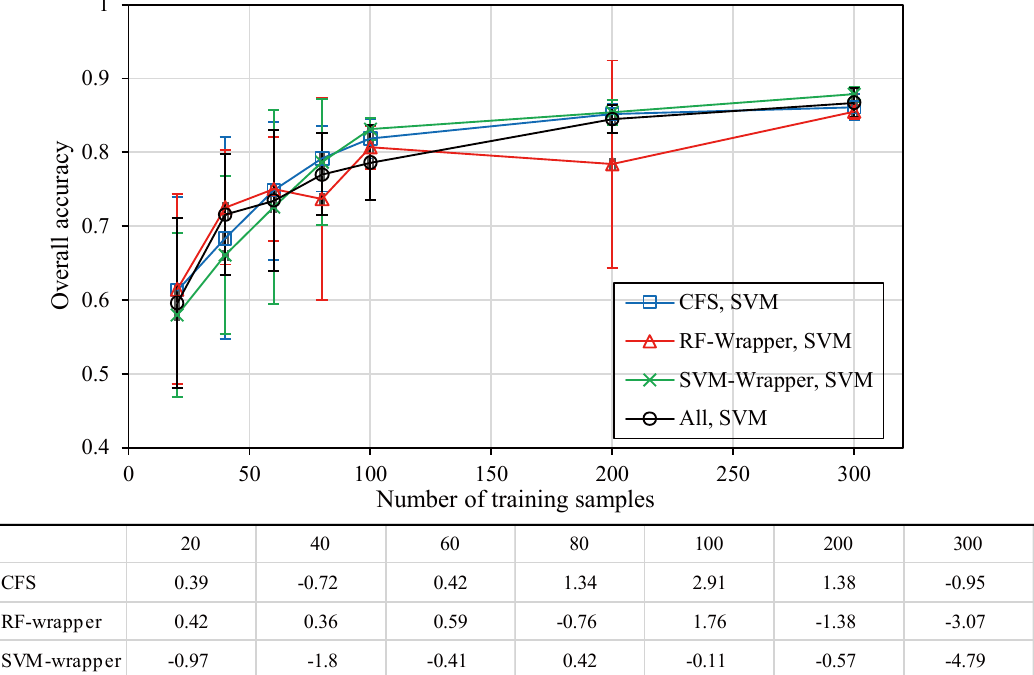
Figure 5. The overall accuracy versus the training set size obtained by the different feature subsets using the SVM classifier and the statistical value derived from a two-tailed t -test reveals whether there is a significant difference in the classification accuracy between the selected feature subset and the full feature set.